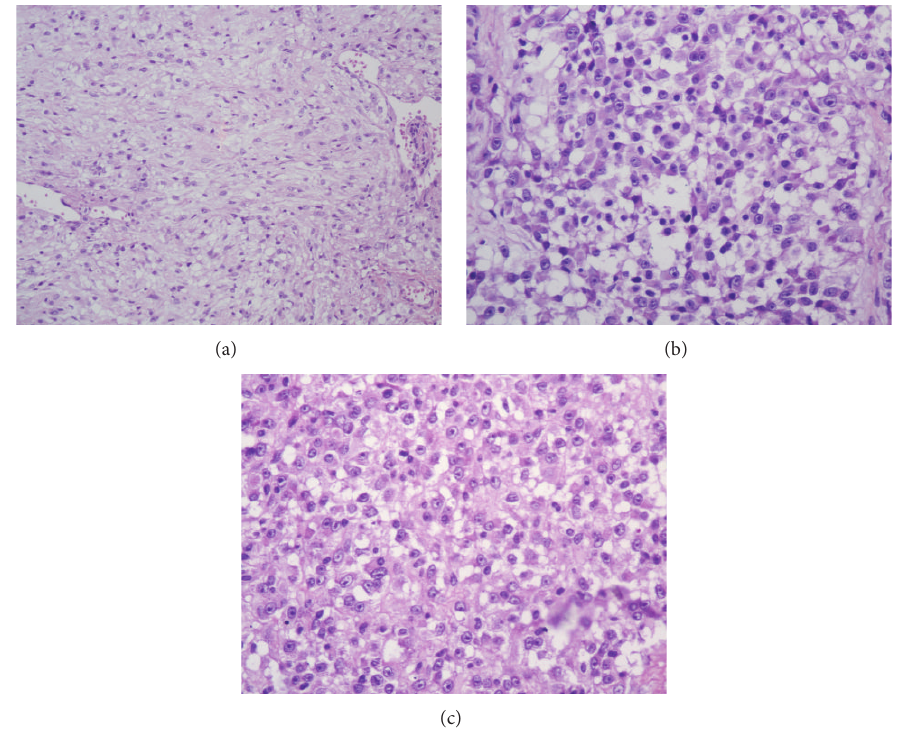
Figure 3: Histologic pictures. Paraffin sections with spindled or polygonal epithelioid cells in a myxoid stroma ((a) H&E, × 200; (b) H&E, × 400; (c) H&E, × 400).